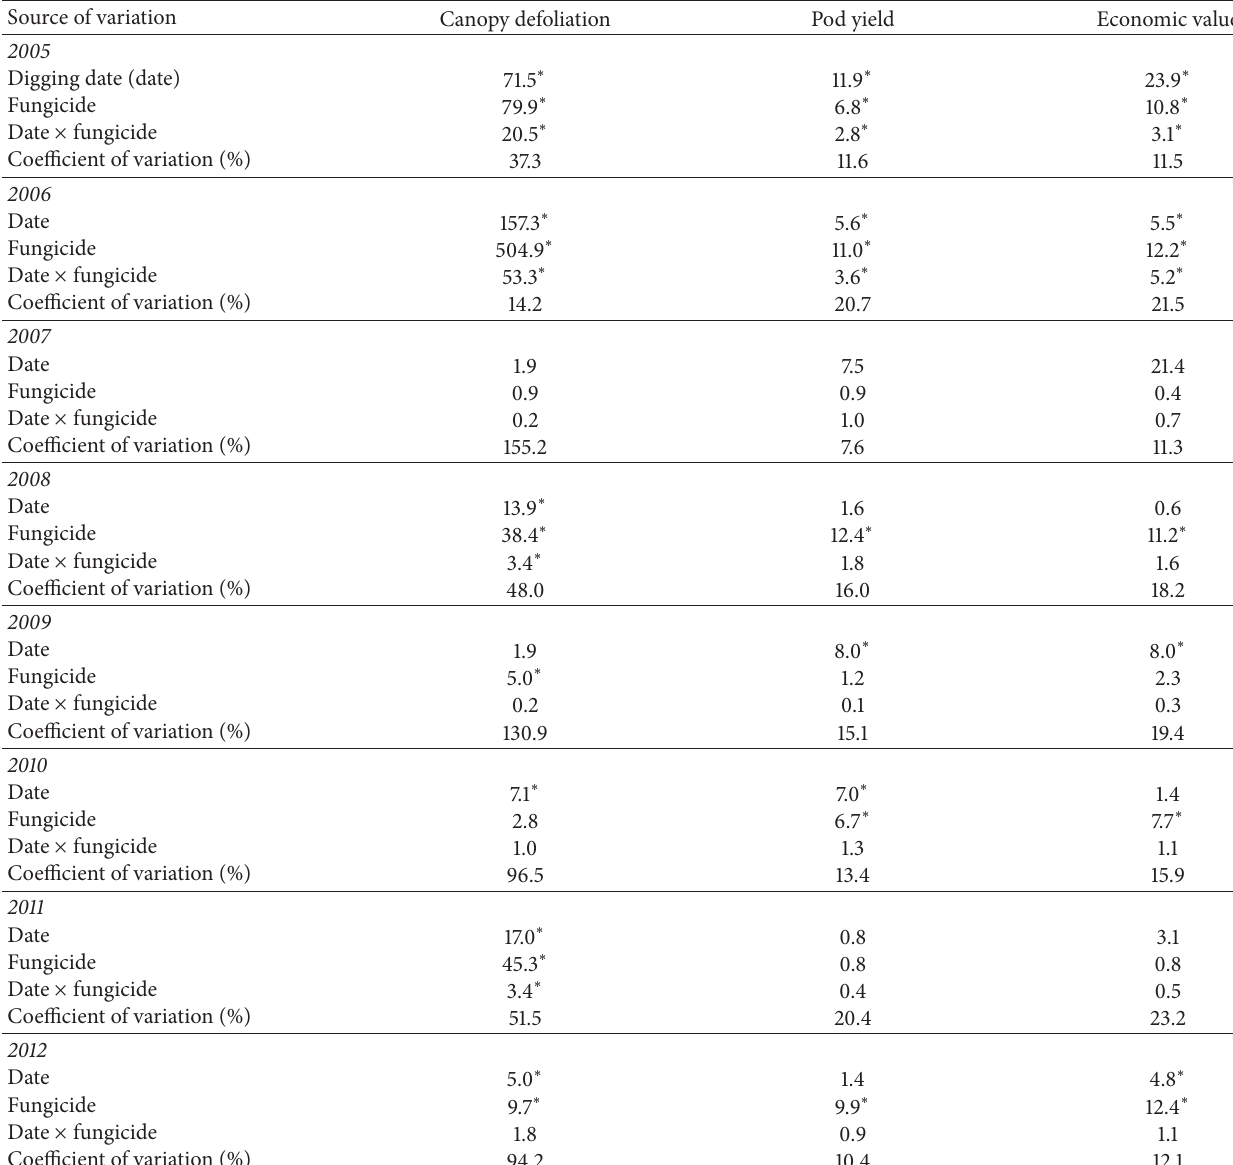
Table 7: Analysis of variance ( 𝐹 -value) for percent canopy defoliation (%), pod yield (kg/ha), and economic value ($/ha) for the cultivar Gregory as influenced by the interaction of year, digging date, and fungicide regime. Source of variation Canopy